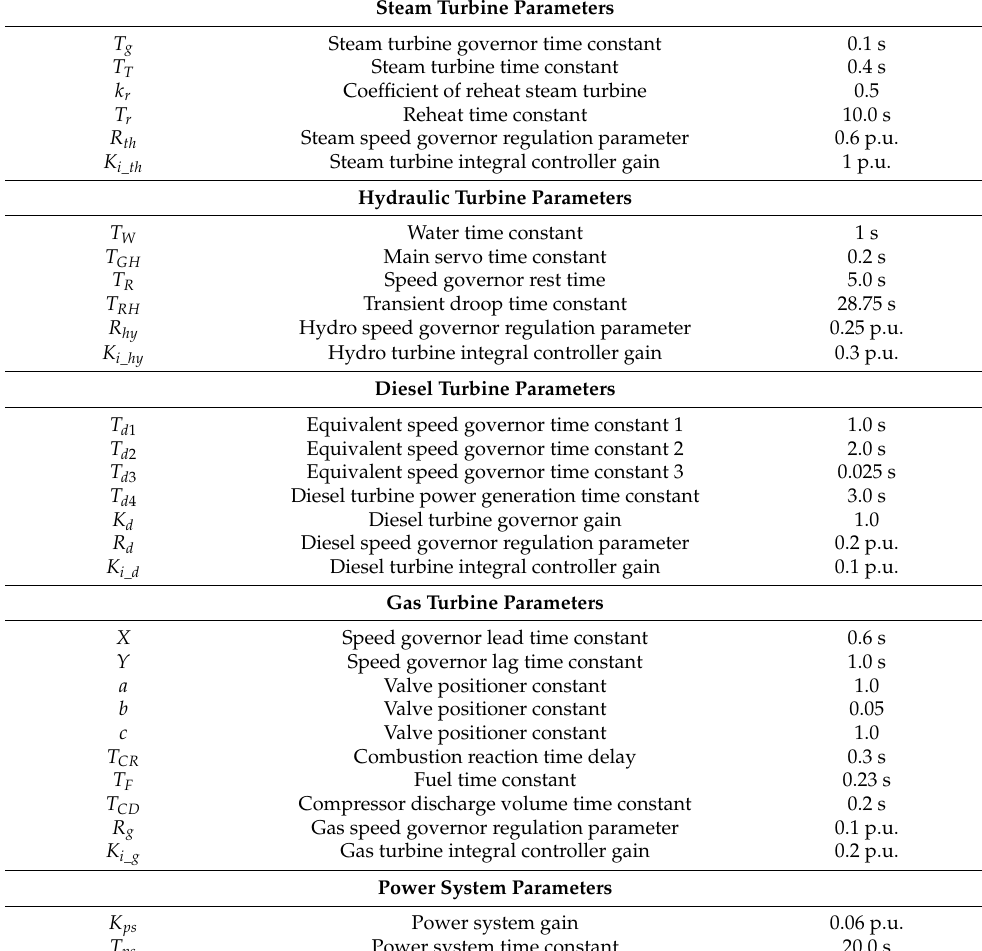
Table 4. Power system